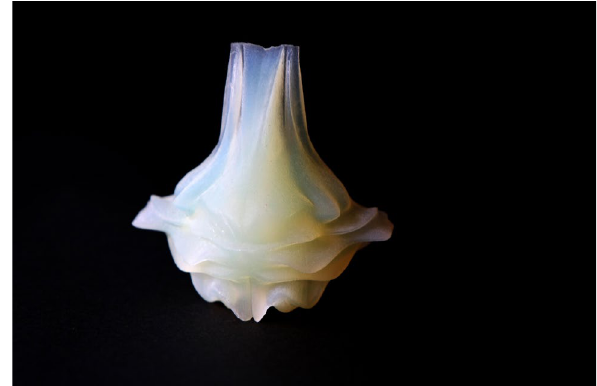
Figure 6 | Nose project Boxer – photo of 3d printed object in flexible material tango plus 9740. Technology polyjet, solidified liquid photopolymer by using UV light.